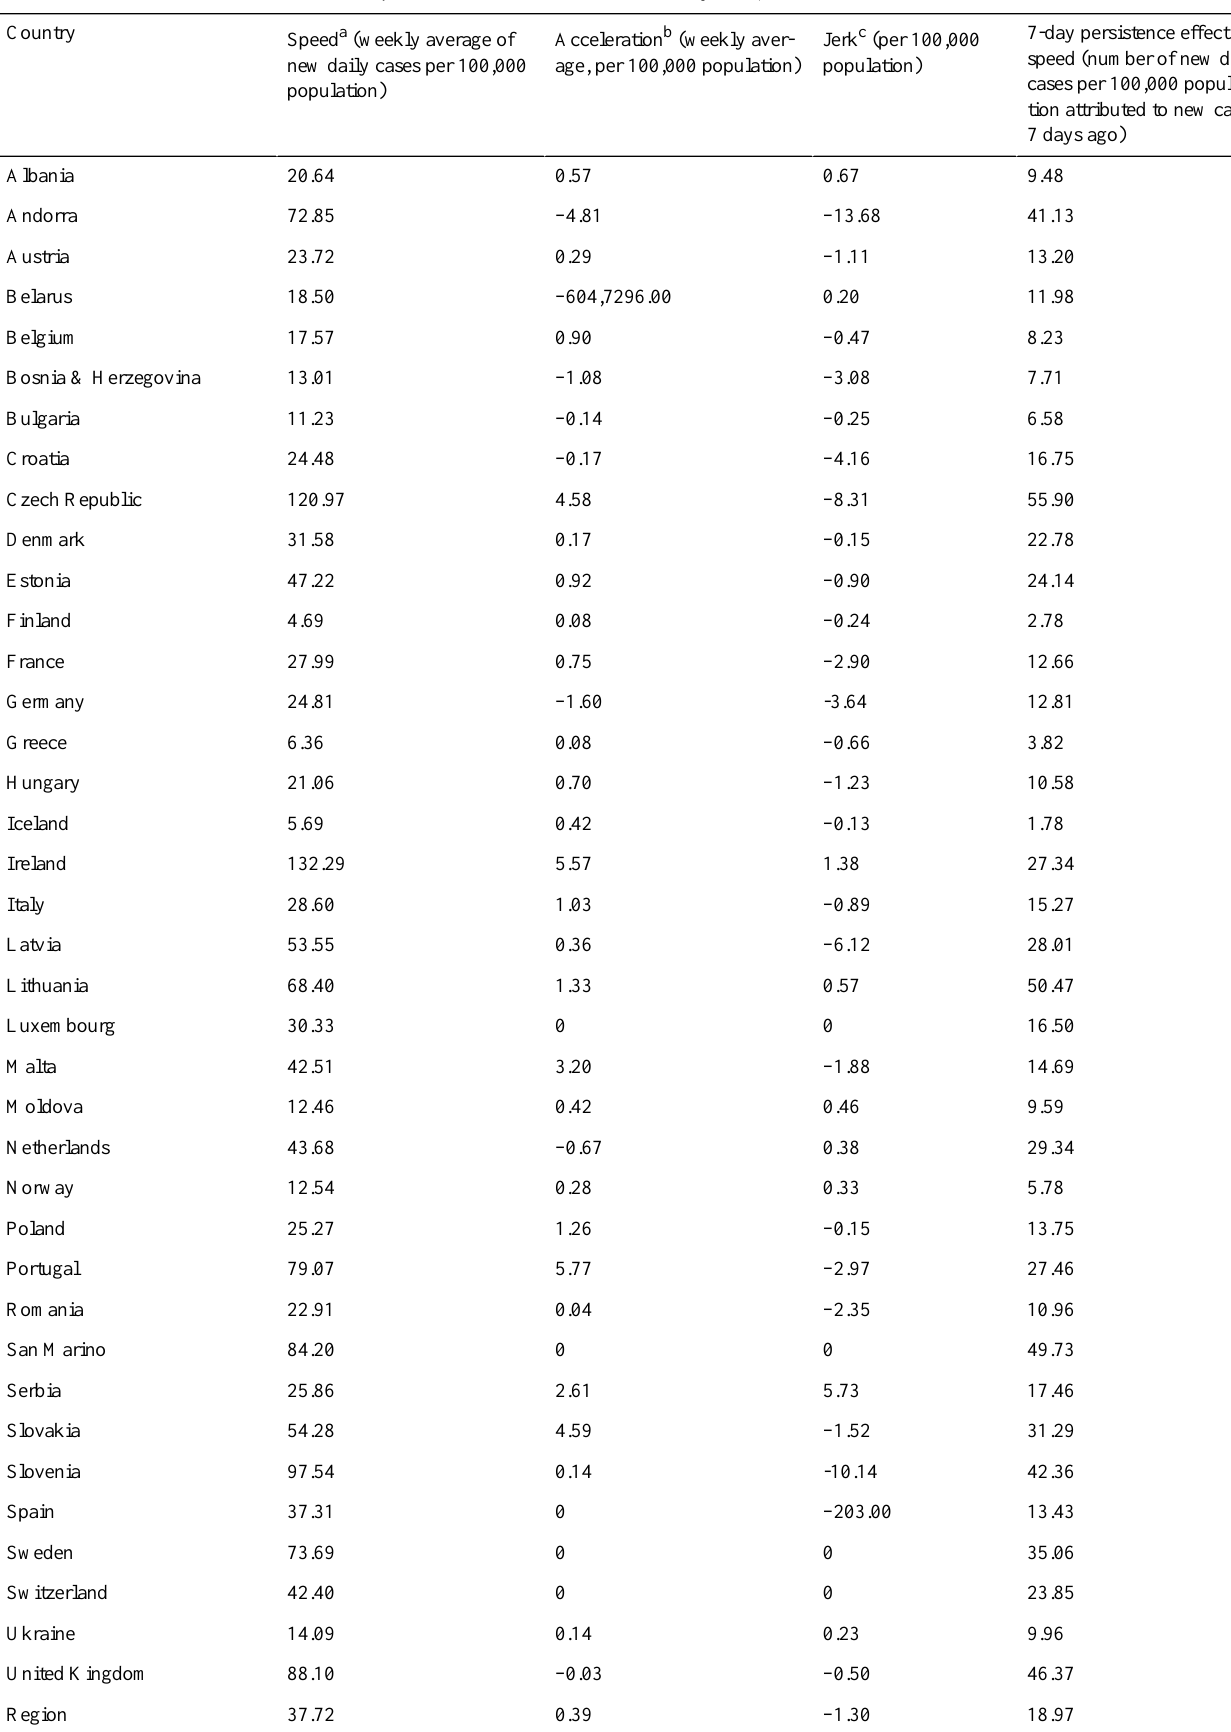
Table 4. Novel surveillance metrics for European countries for the week of January 4-10,